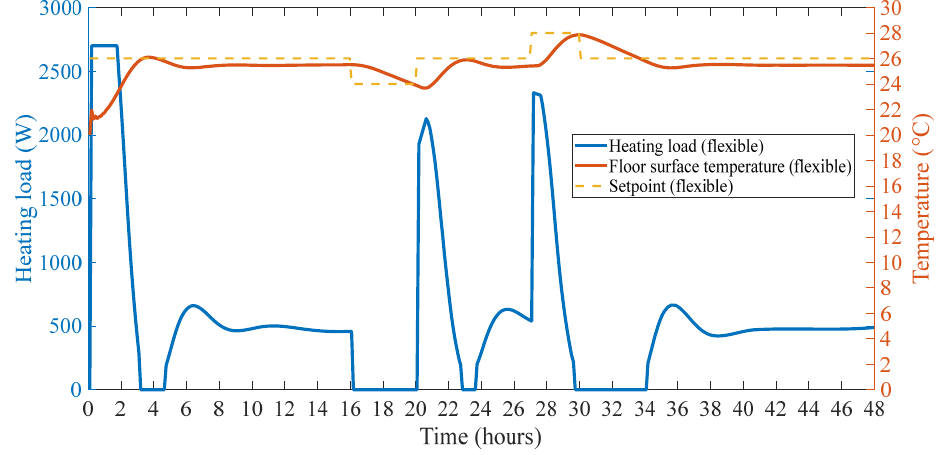
calculated as C ADR,U = 222 Wh/m 2 and the BEFI U = 76 W/m 2 . C ADR,U = 222 Wh/m 2 and the BEFI U = 76 W/m 2 .